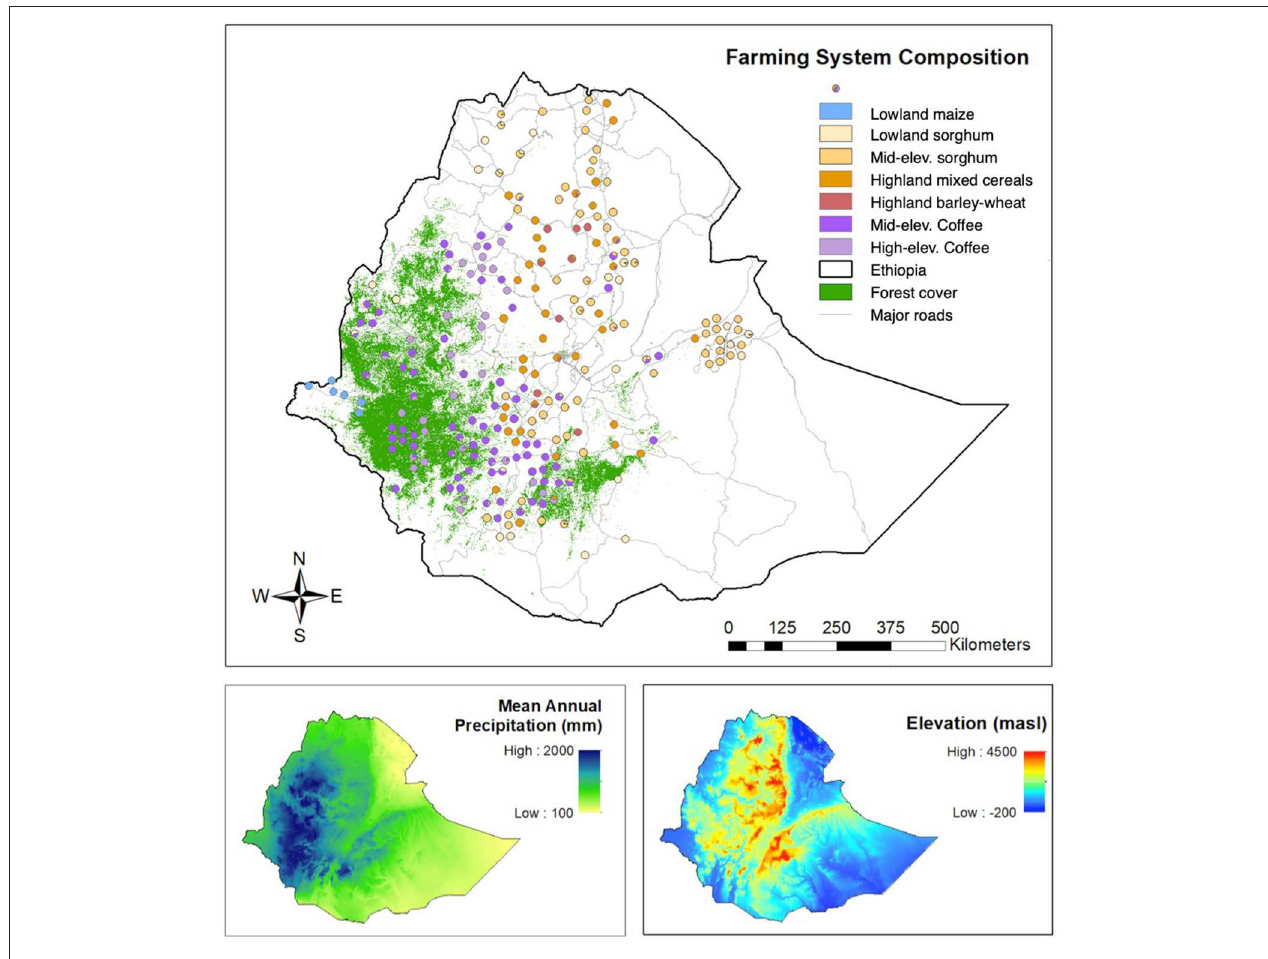
FIGURE 3 | Geographic distribution of the seven farming system types across Ethiopia. The World Bank’s LSMS used an enumerator area (mostly corresponding to a village) as the geographical sampling unit. The pie-chart represents the percentage of households engaged in each farming system type within each enumerator area. The bottom left panel shows the mean annual precipitation (mm) across the country, while the bottom right panel shows the elevation (masl).